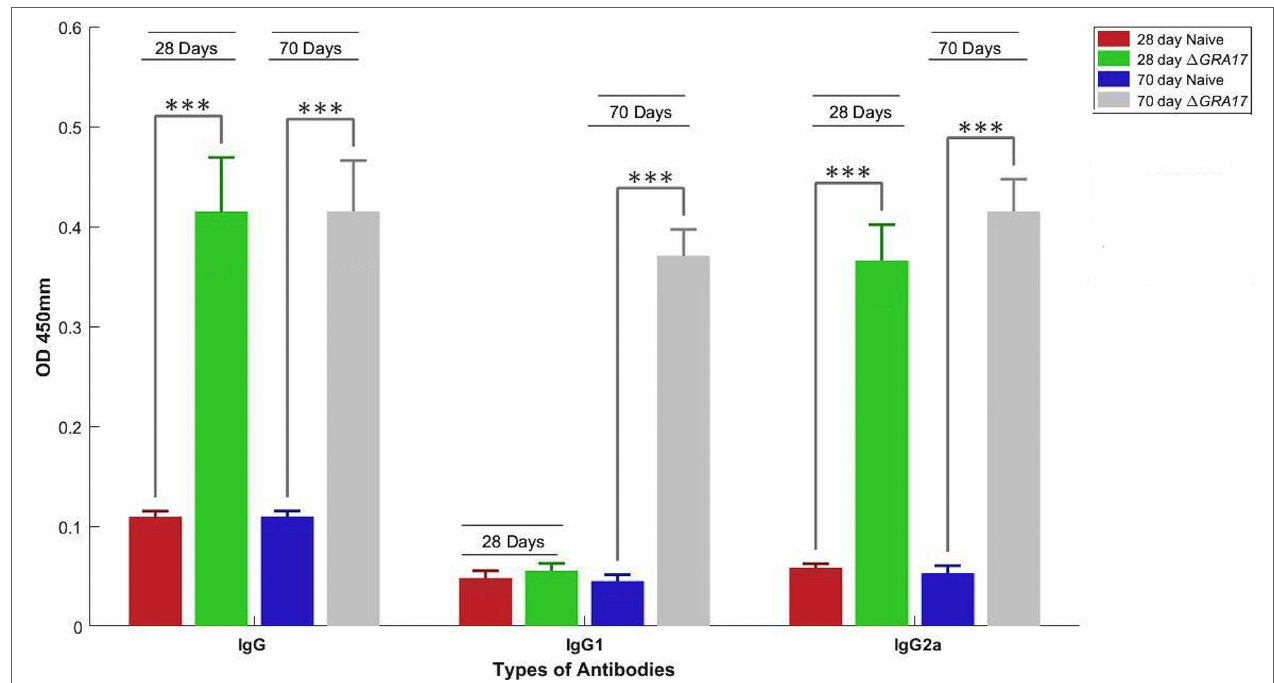
FigUre 4 | Humoral response and antibody isotype profile in serum of mice immunized with Δ GRA17 by intraperitoneal route. Levels of IgG and IgG subclass (IgG1 and IgG2a) antibodies in the sera of mice at 28 and 70 days after Δ GRA17 -immunization compared to naïve mice. The patterns of IgG2a to IgG1 at 28 and 70 days postimmunization suggest the induction of a Th1 immune response at 28 days postimmunization, which remained high and the induction of Th2 immune response at day 70 postimmunization. Results are expressed as mean of OD450 ± SD. Significance compared with naïve control mice: *** p <